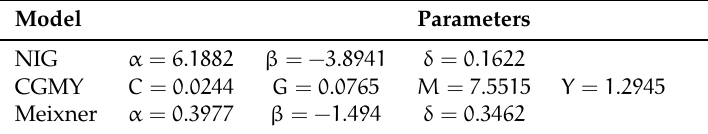
Table 1. Estimated parameters for Levy processes.